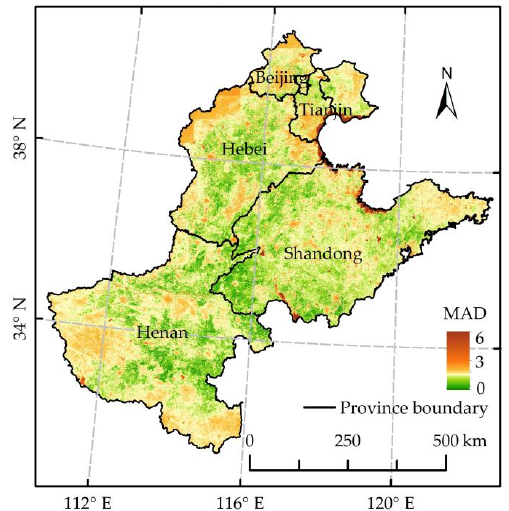
Figure 9. The mean absolute distance (MAD) map in Huanghuaihai Plain in 2012.